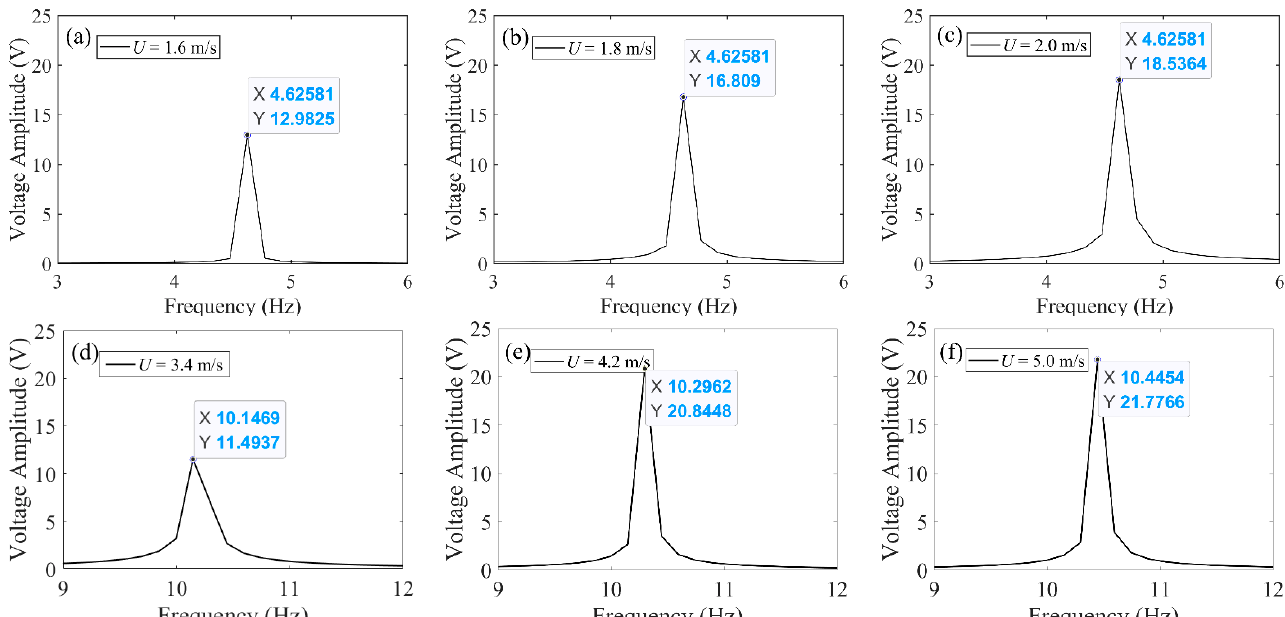
Figure 13. Fast Fourier transform (FFT) of the steady-state part of the voltage–time response under different wind speeds: ( a ) 1.6 m/s, ( b ) 1.8 m/s, ( c ) 2.0 m/s, ( d ) 3.4 m/s, ( e ) 4.2 m/s, and ( f ) 5.0